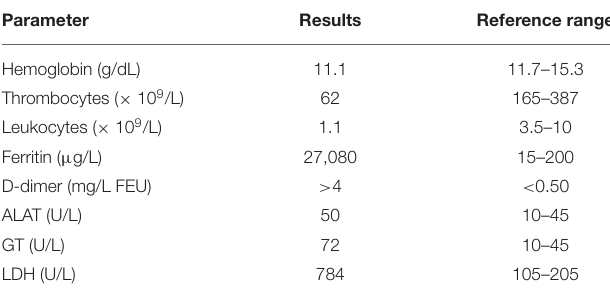
TABLE 1 | Initial blood tests of the patient upon